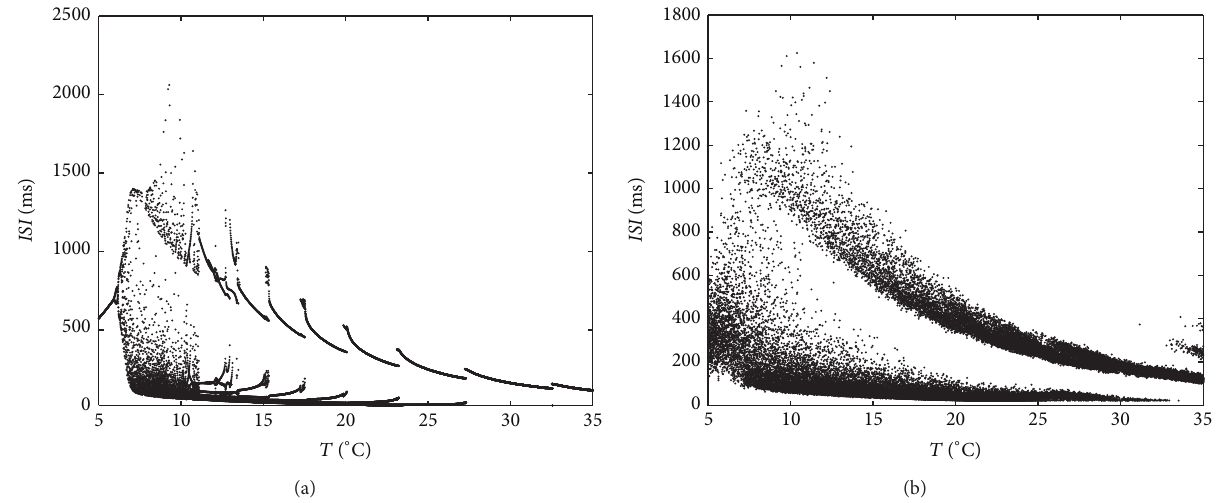
Figure 1: ISI plots with respect to variation of the temperature 𝑇 in the deterministic situation and the noise situation with 𝑑 = 0.5 .